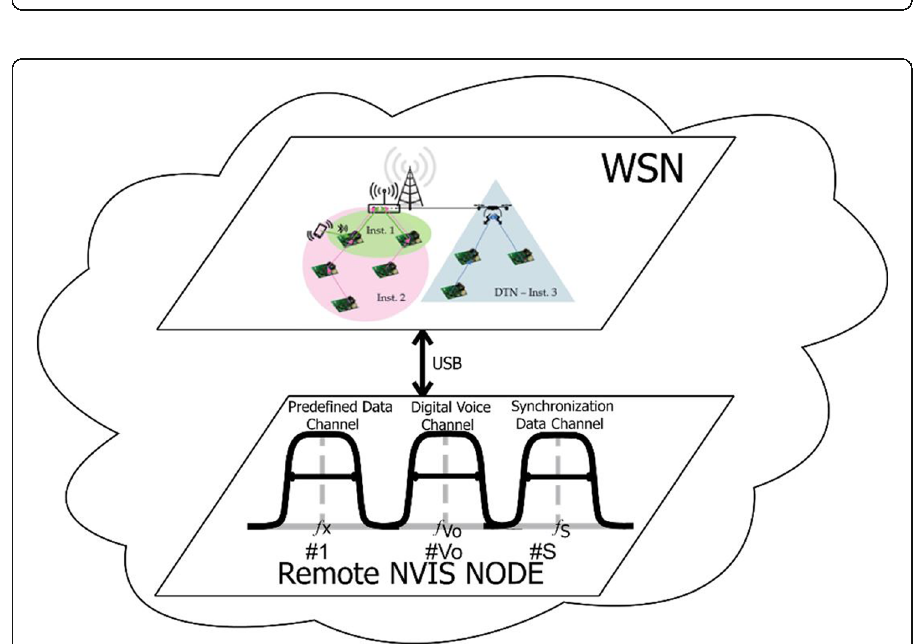
Fig. 16 Remote NVIS node. Connections between the NVIS node and the WSN network. Sensor data acquisition and transmission to the NVIS remote